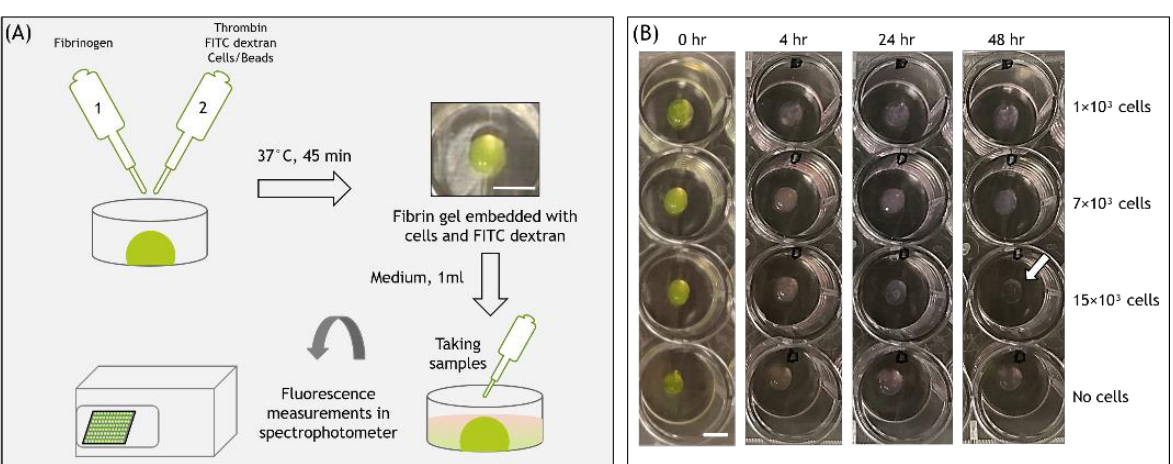
Figure 1. ( A ) Schematic of the experimental setup. ( B ) Images of fibrin gel 20μL embedded with FD 250 kDa and cells, at different time points from cell seeding. Scale bars are 500 m.